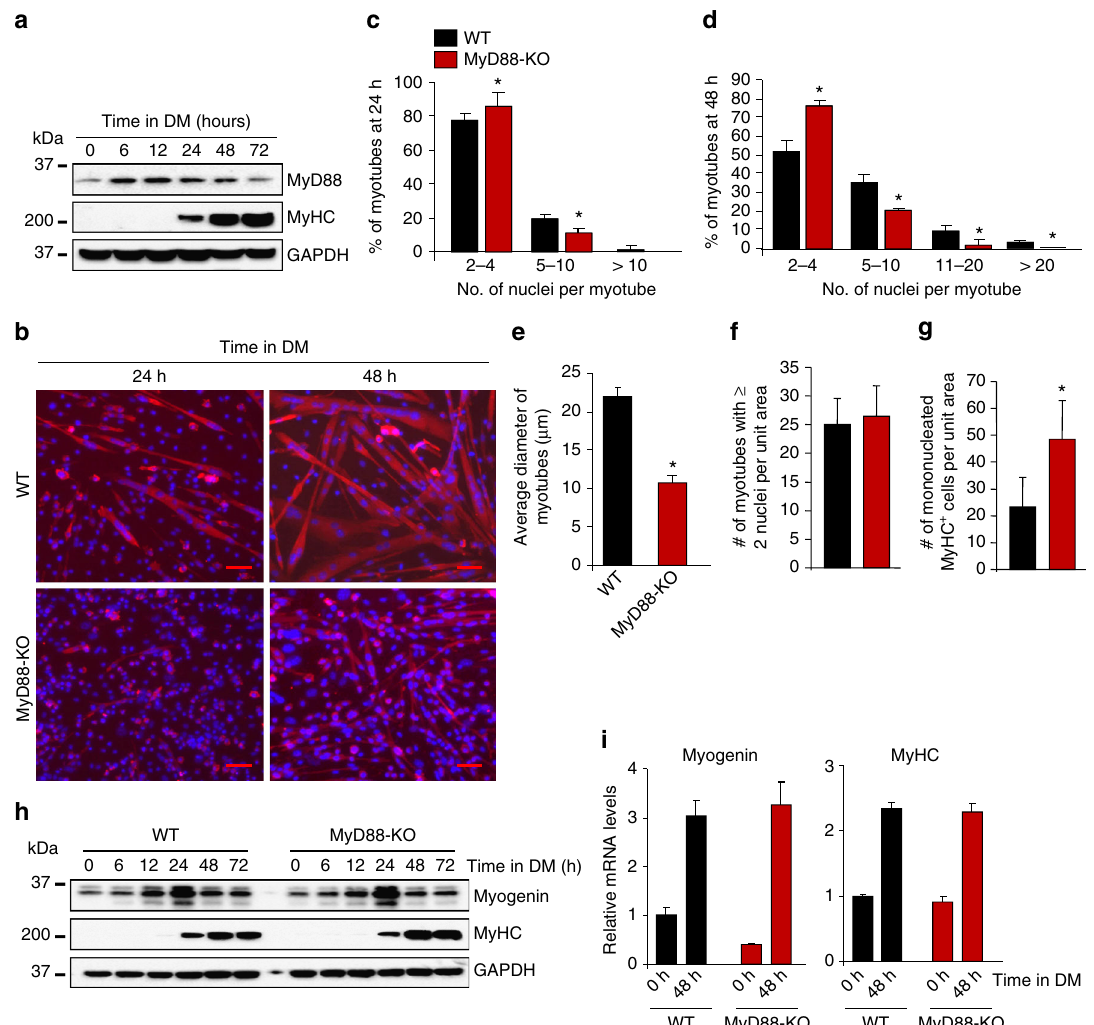
Fig. 2 MyD88 mediates myoblast fusion in vitro. a Primary myoblasts were prepared from hind limb muscles of WT mice. The cells were incubated in DM and samples were collected at indicated time points and processed by Western blot to detect MyD88, MyHC as a differentiation marker, and an unrelated protein GAPDH. b Primary myoblasts prepared from hind limb muscle of WT and MyD88-KO mice were plated at equal densities and incubated in DM for 24 h or 48 h followed by staining for MyHC and DAPI. Representative photomicrographs are presented here. Scale bar: 50 µ m. c Quanti fi cation of the percentage of myotubes containing indicated number of nuclei per myotube in WT and MyD88-KO myotubes cultures after 24 h of addition of DM. d Quanti fi cation of the percentage of myotubes containing indicated number of nuclei per myotube in WT and MyD88-KO cultures after 48 h of addition of DM. e Average diameter of myotubes in WT and MyD88-KO cultures after 48 h of addition of DM. f Quanti fi cation of number of MyHC + myotubes containing 2 or more nuclei and g number of mononucleated MyHC + cells per unit area (~0.15 mm 2 ) in WT and MyD88-KO cultures after 48 h of incubation in DM. h Primary myoblasts prepared from WT and MyD88-KO mice were incubated in DM and samples were collected at indicated time points. Protein lysates were prepared and blotted with antibodies against MyHC, myogenin and unrelated protein GAPDH. i In a separate experiment, WT and MyD88-KO cells were collected at 0 and 48 h following addition of DM and mRNA levels of MyHC and myogenin were measured after normalizing to the levels of β -actin. Results are from four to fi ve independent experiments. Error bars represent s.d. * p < 0.05 from corresponding WT cultures for